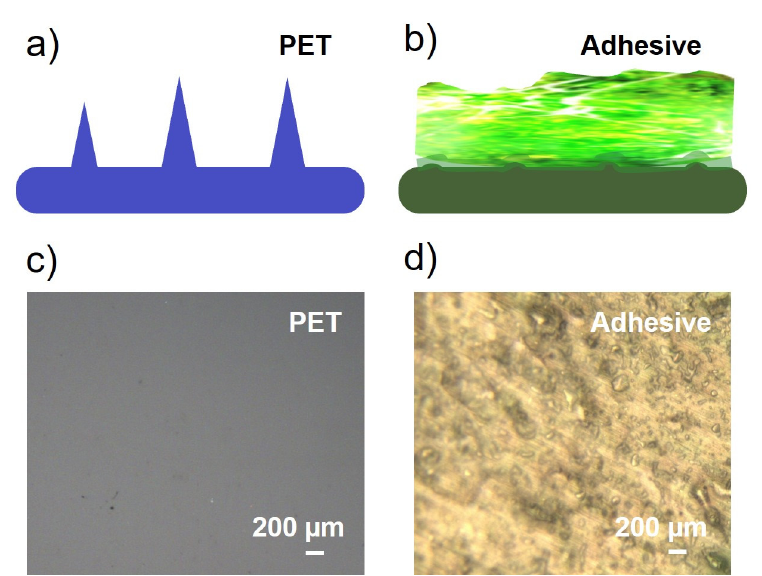
Figure A2. Pressure and peel strength curve during the pull-off test to demonstrate the adhesive strength of the PAMD-based metal electrode. The maximum pressure was 22.5 MPa, the maximum pull-off load was 0.7 MPa, and the speed at which the tape was pulled was set at 5 cm/min.